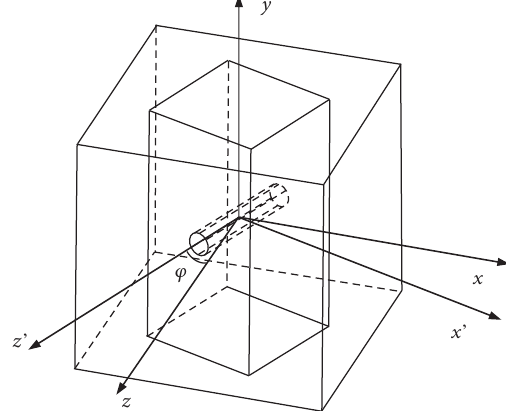
Figure 10: Schematic diagram of the rotation of in situ stress